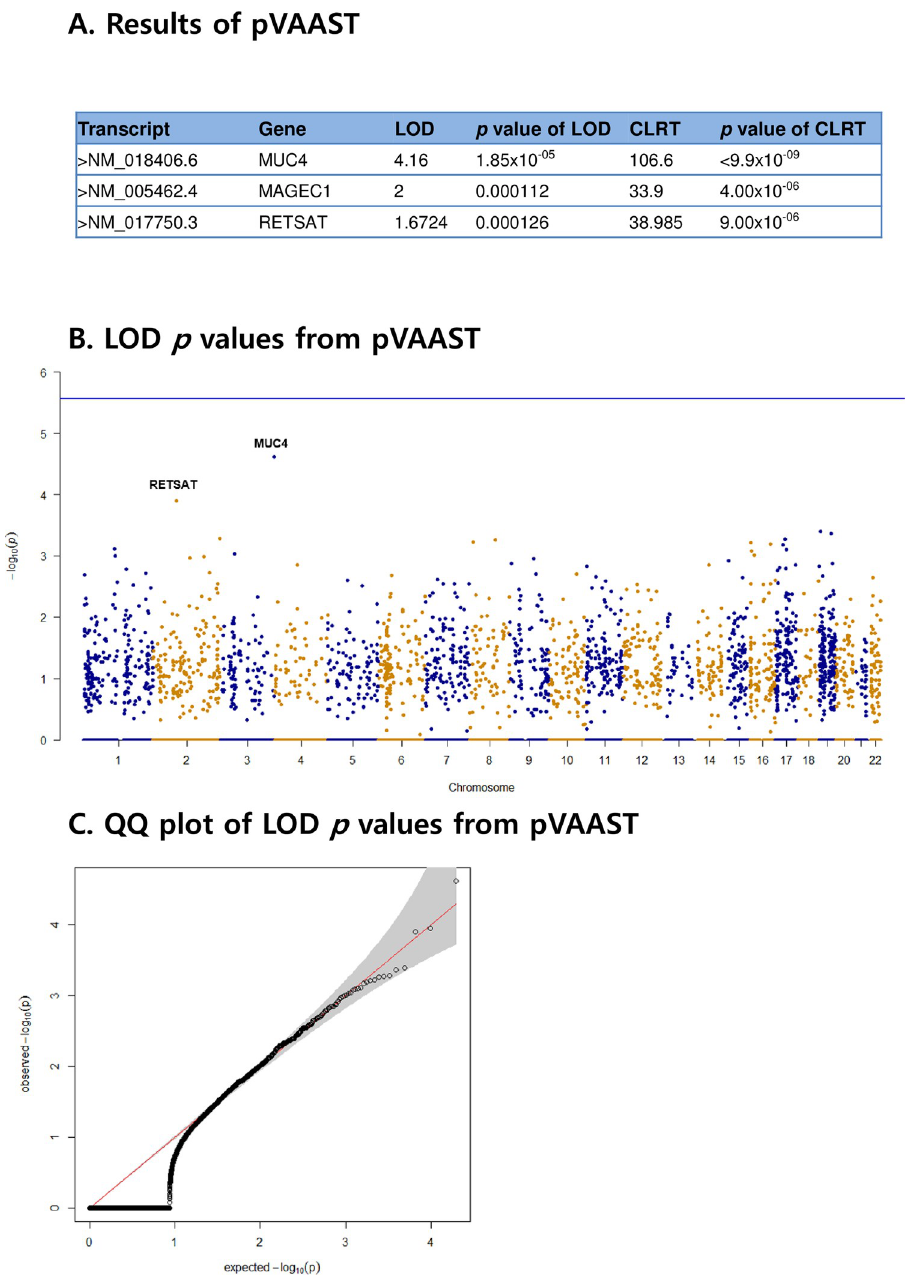
Fig 2. Candidate predisposition genes for gastric cancer by combined linkage analyses with pVAAST. (A) Predisposition genes that were detected are described. A composite likelihood ratio test (CLRT) based on the binomial likelihood for allele counts in cases and controls weighted by the functional prediction likelihood ratio was conducted with 10 6 permuted samples by the gene drop method. (B) Manhattan plot of the logarithm of odds (LOD) p values of all protein-encoding genes from the pVAAST run; each dot in the plot represents a p value for one gene. The x-axis shows the genomic locations arranged by chromosome. (C) quantile-quantile (QQ) plot of the LOD p values from